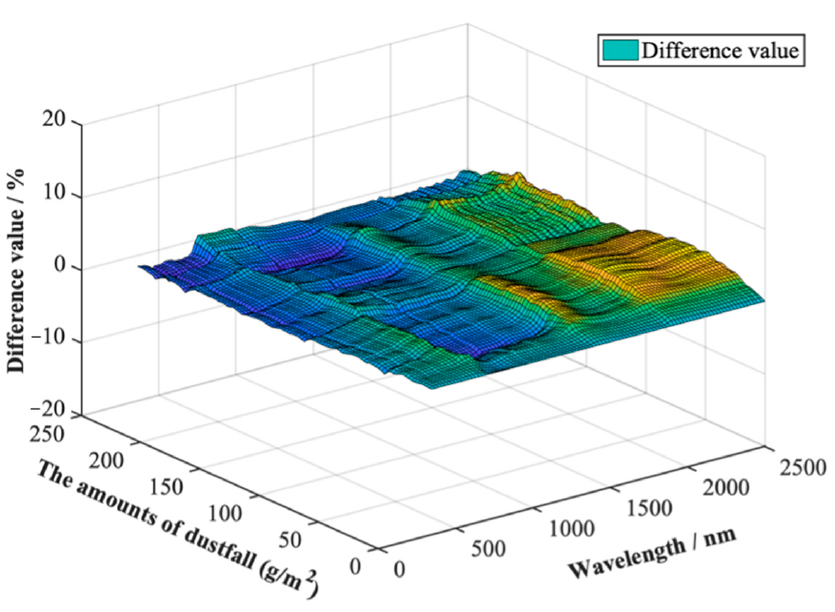
Figure 10. Two-dimensional surface diagram of the difference between the corrected and measured values of the Hapke two-layer medium model simulated spectra.